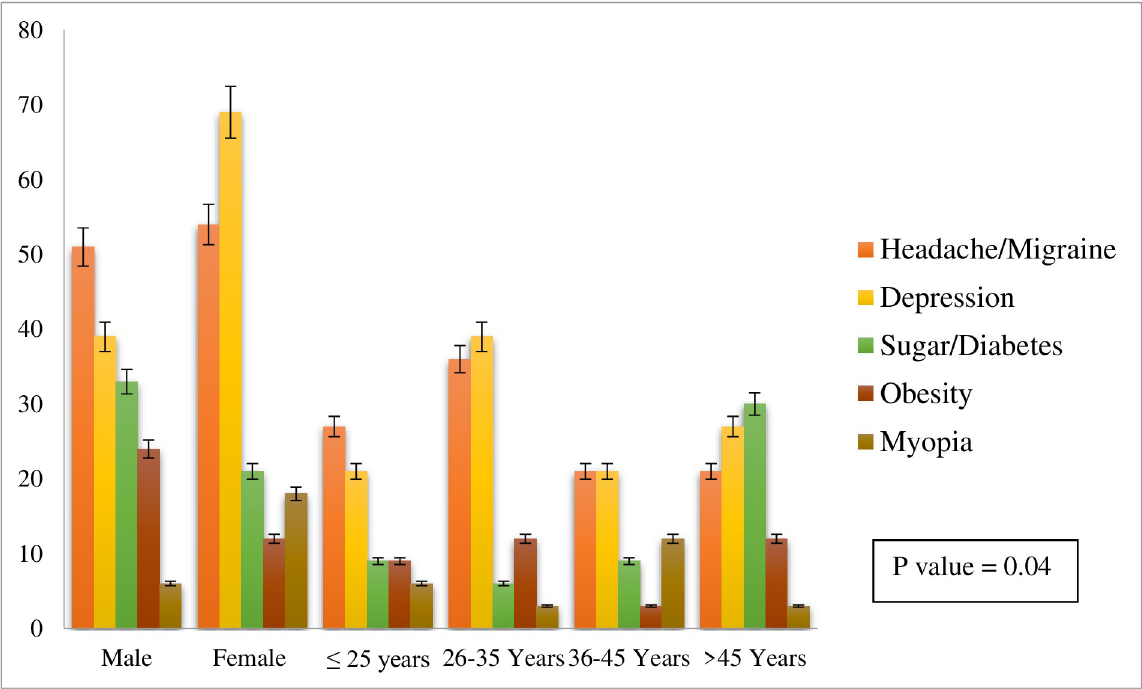
Fig 2. Associated diseases with sleep